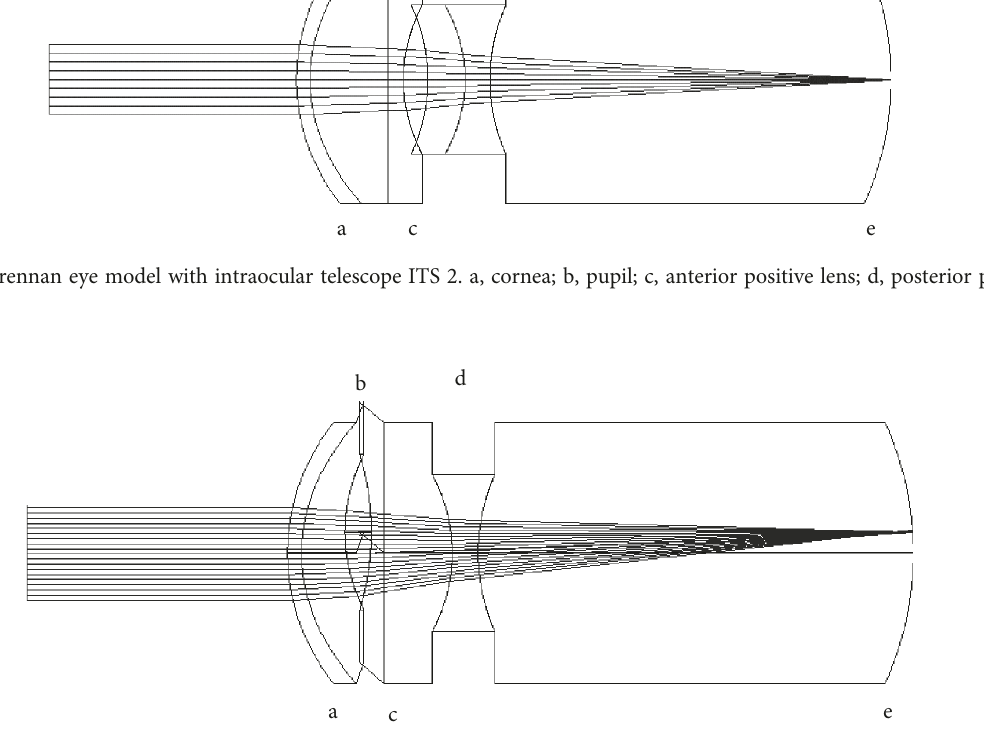
Figure 3: ITS 1 with decentered anterior lens. a, cornea; b, anterior positive lens; c, pupil; d, posterior negative lens; e,